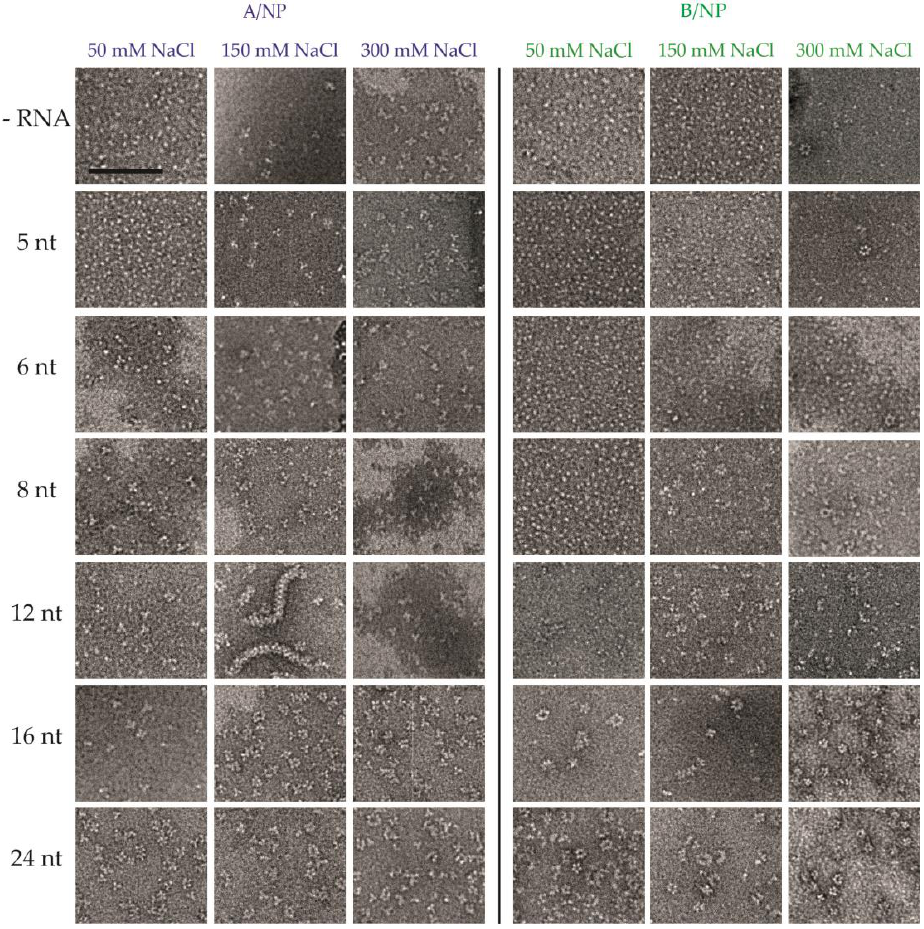
Figure 4. Electron microscopy of the nucleoproteins of influenza A and B viruses in the absence or presence of different RNA and different buffers. The A/NP or B/NP were incubated overnight at room temperature with or without 5′ phosphate-polyUC-FAM 3′ in 20 mM Tris-HCl pH 7.5, 5 mM β-mercaptoethanol (β-ME), and different NaCl concentrations from 50 to 300 mM. Samples were negatively stained with sodium silicotungstate. Electron micrographs show different oligomeric states depending on the salt concentration and the RNA used. The scale bar corresponds to 100 nm.